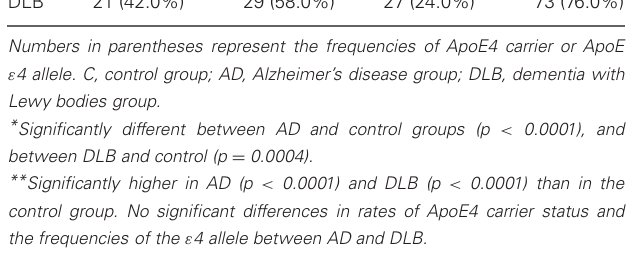
plasma level of annexin A5. The areas under the curve are 86.3 and 83.8% for AD and DLB, respectively. AD, Alzheimer’s disease; DLB, dementia with Lewy bodies.